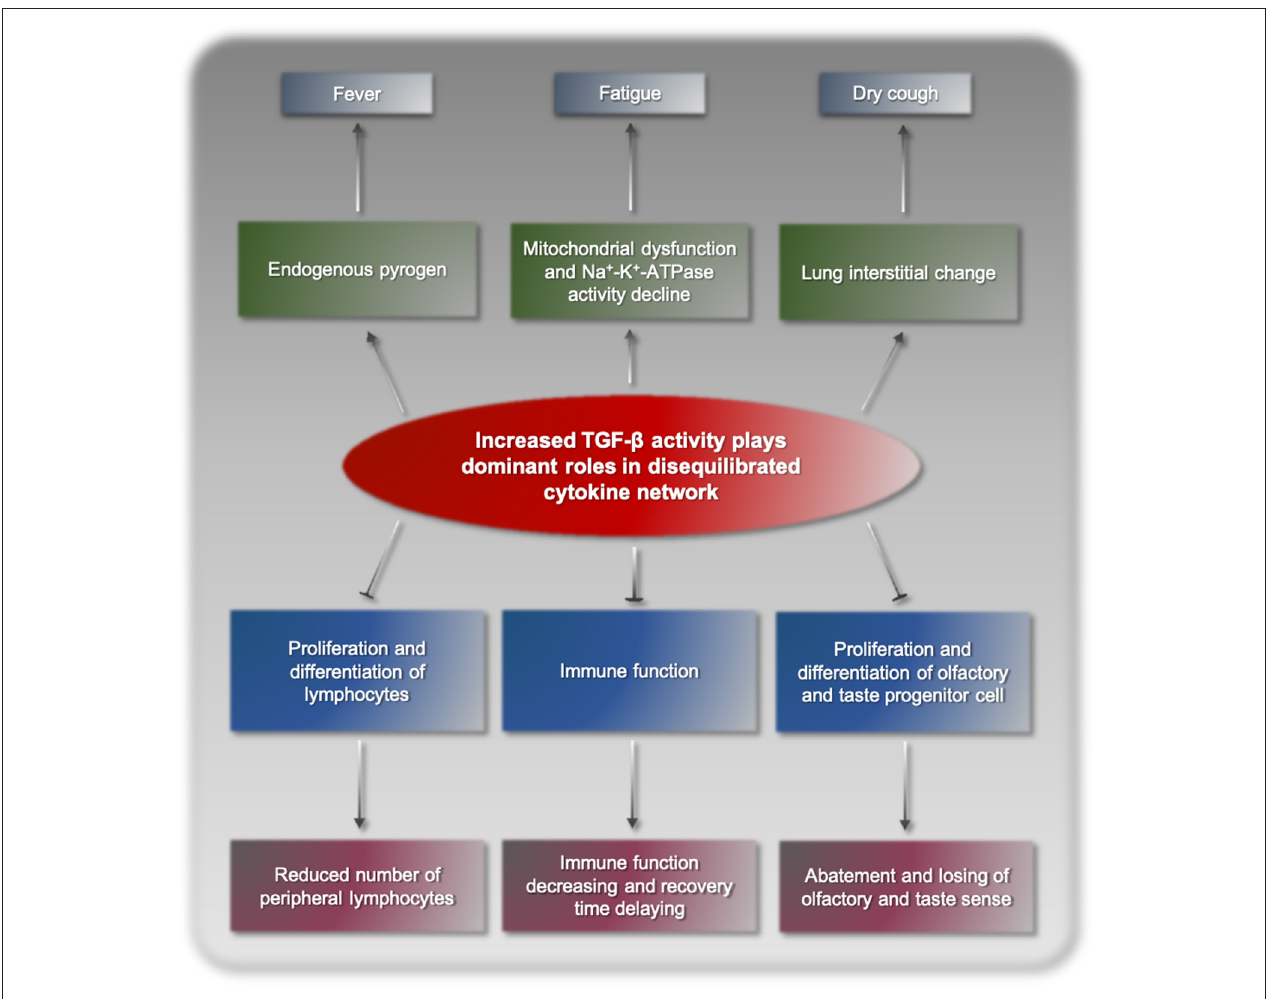
FIGURE 1 | The pathogenic mechanism of COVID-19 manifestations. complications, such as serious infections and shock. In addition, TGF- β is a strong immunosuppressive factor in the body, significantly suppressing immune function and delaying recovery (16). Furthermore, TGF- β can inhibit the proliferation and differentiation of lymphocytes (17), reducing the number of peripheral blood lymphocytes. TGF- β has negative impacts on olfactory and gustatory receptor neurons and neurogenesis by inhibiting progenitor cell proliferation and differentiation, elicits the abatement and losing of olfactory and gustatory sense in some patients (18–20). Overall, the clinical manifestations of COVID- 19 are highly consistent with increased TGF- β activity, which is the basic evidence supporting TGF- β as the main player of cytokine storm resulting from SARS-CoV-2